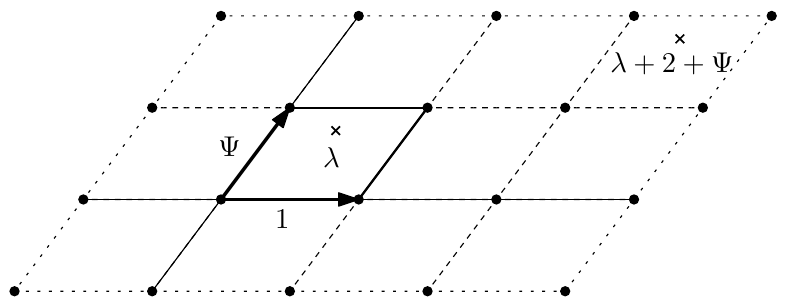
Figure 3. The lattice structure of modules of the b gl (1) algebra. GW-defects are labeled by a point in the torus of modular parameter (cid:9). Fusion with electric and magnetic modules of charges n and (cid:9) n lift the torus along the full complex plane parametrizing generic module of the algebra. Lattice points correspond to dyon modules of the algebra and the position in the fundamental domain corresponds to the GW-parameter. For example, the modules of charge ~ (cid:21) = (cid:21) + 2 + (cid:9) and (cid:21) in the fundamental domain are related by fusion with the electric module of charge 2 and the magnetic module of charge